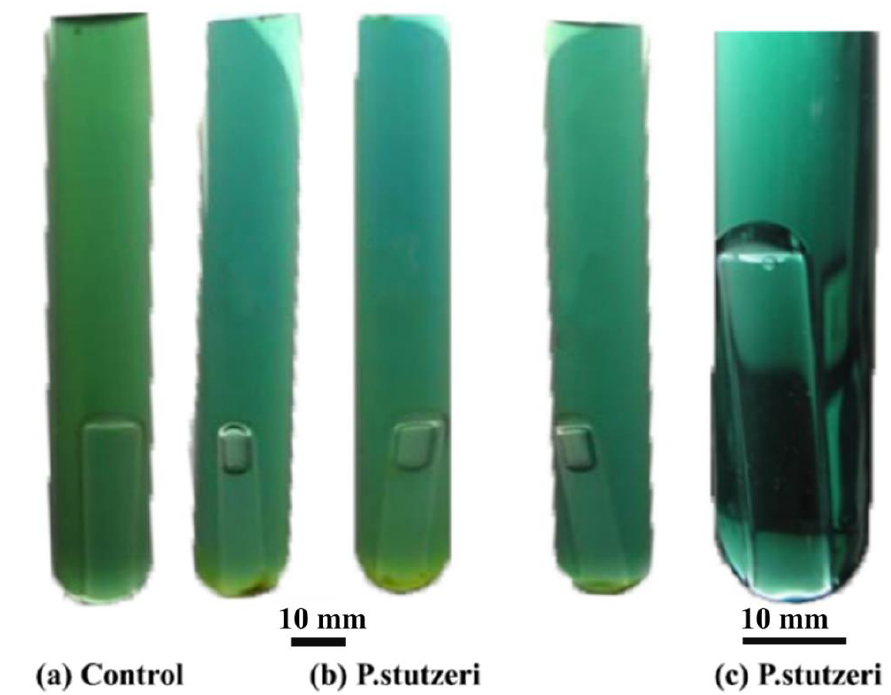
Figure 2. Identification of denitrifying bacteria using Giltay medium. ( a ) The blank Giltay medium; ( b ) medium for inoculation with P. stutzeri ; ( c ) local amplification of ( b ).